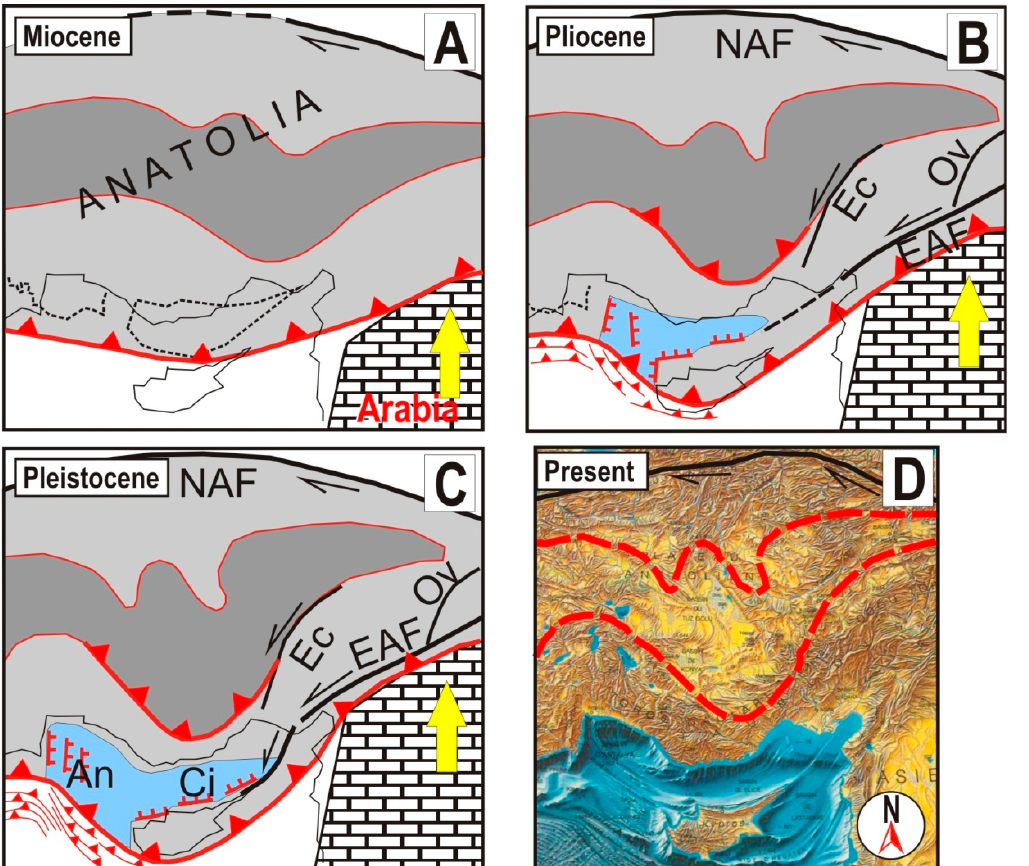
Figure 12. Tentative reconstruction of the tectonic mechanism that generated the Cyprus arc and the Antalya (An) and Cilicia (Ci) basins ( A – C ) and present morphological setting (( D ), modified from [191]). EAF—East Anatolian fault; Ec—Ecemis fault; NAF—North Anatolian fault; Ov—Ovacek fault. Symbols as in Figure 5; Figure 11.